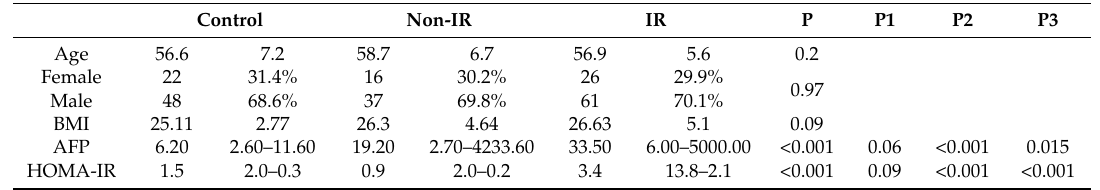
Table 1. Demographic data, AFP, BMI, and homeostasis model of IR (HOMA-IR) in insulin resistant (IR), non-insulin resistant (non-IR) and control